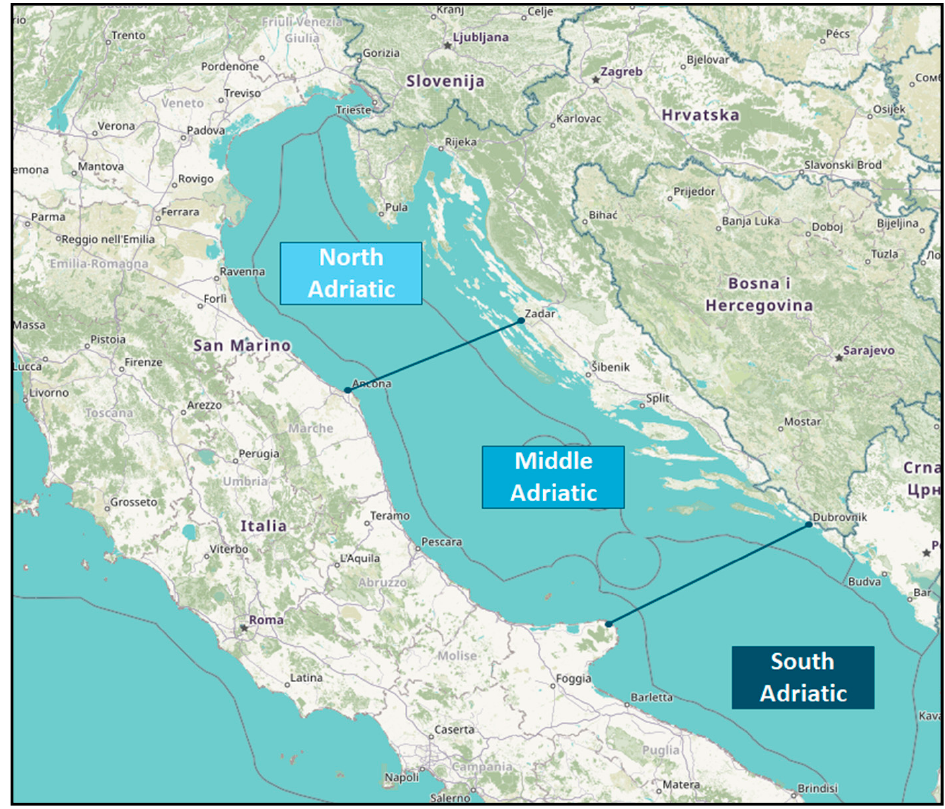
Figure 2. Main Adriatic regions.